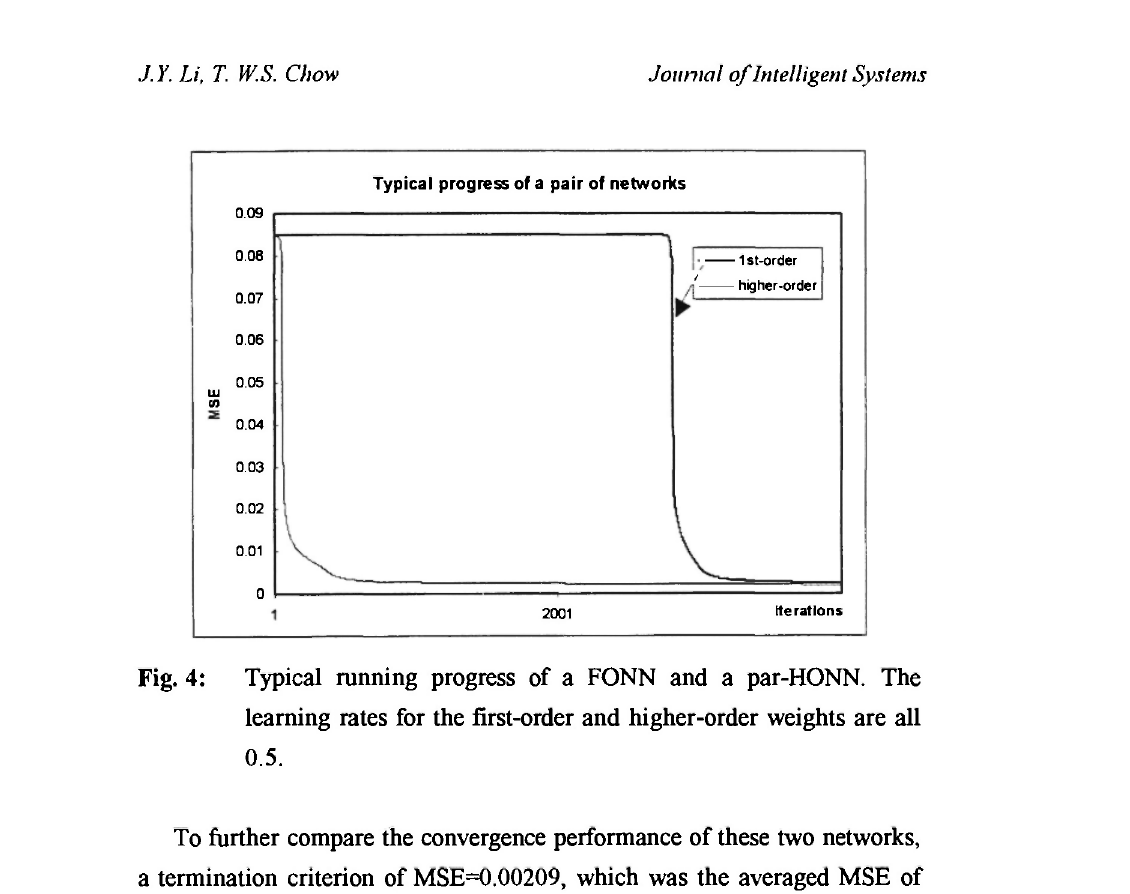
To further compare the convergence performance of these two networks, a termination criterion of MSE=0.00209, which was the averaged MSE of par-HONN, was used for FONN. For the same 100 sets of networks with different initial weights, the averaged number of iterations required to meet the termination criterion was found to be 6352 number of iterations for FONN, which was substantially more than that of the